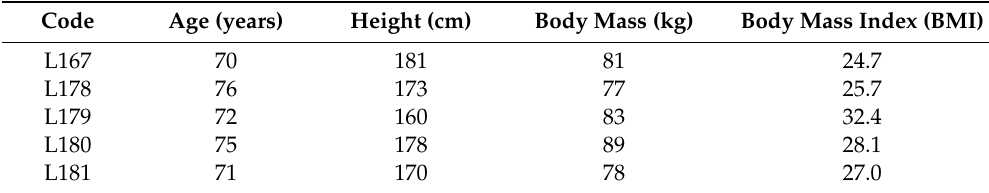
Table 1. Anthropometric characteristics of healthy sedentary